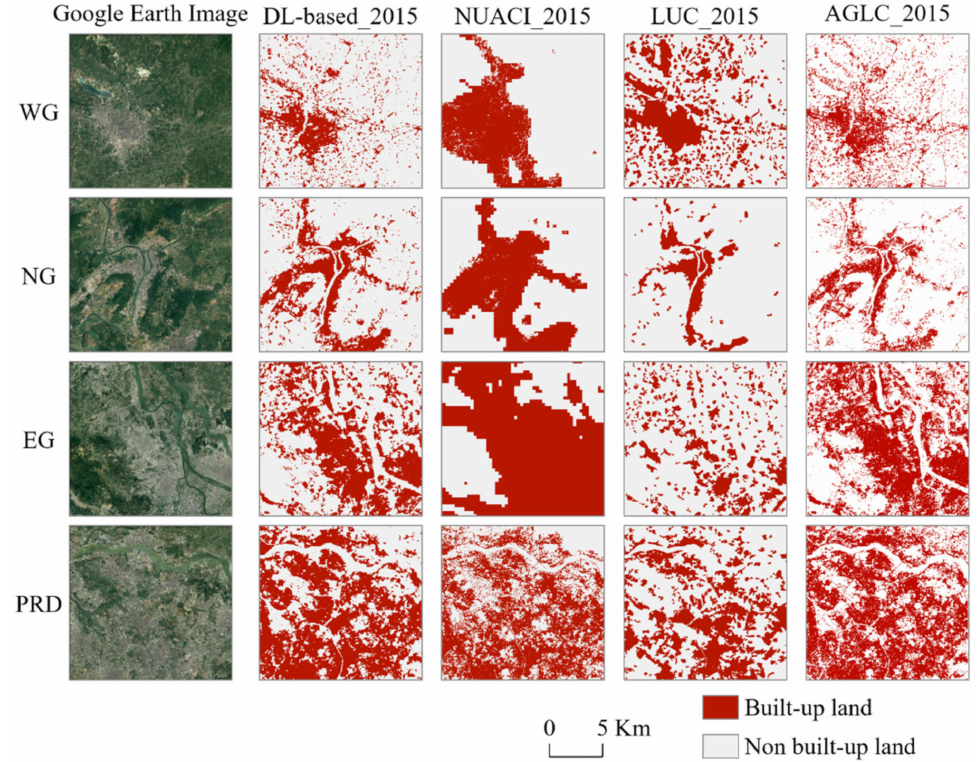
Figure 16. Comparison of built-up land mapping examples of three important data products in four sub-regions in 2015. DL-based_2015 is the data of this study, which identified built-up land; NUACI_2015 is the product of the global 30 m urban land; LUC_2015 is the product of